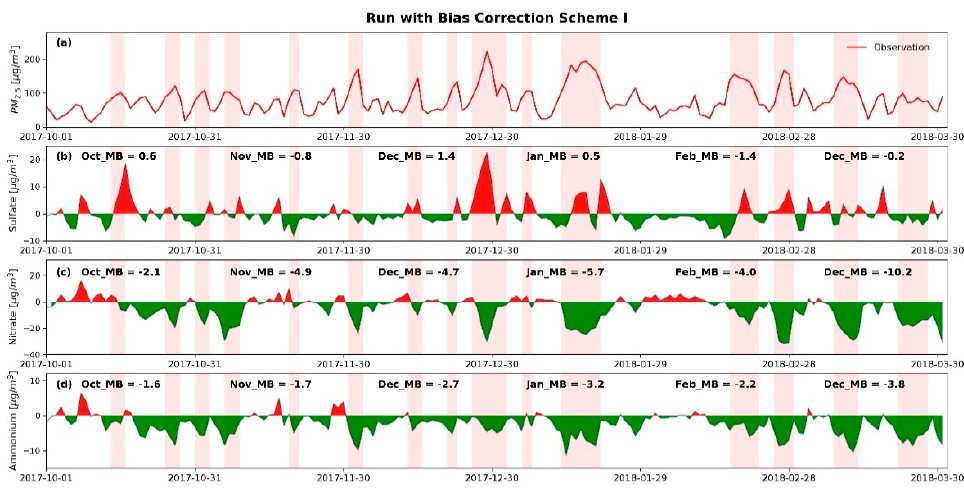
Figure 4. ( a ) Observed PM 2.5 at corresponding sites from 1 October 2017 to 31 March 2018. The red background represents the pollution period. ( b – d ) Model bias (the mean value of 28 sites) simulated under bias correction scheme I of sulfate, nitrate and ammonium from 1 October 2017 to 31 March 2018. The red area indicates a positive bias, and the green area indicates a negative bias.